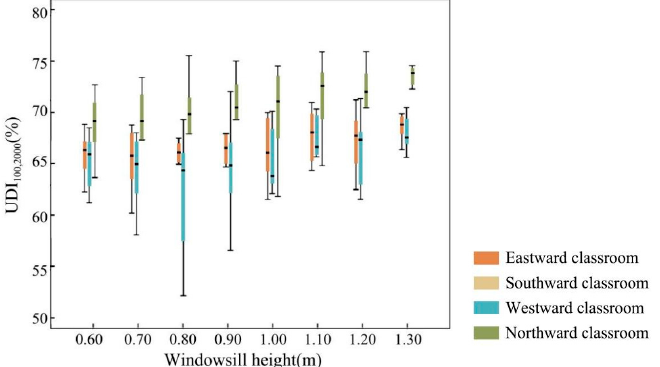
Figure 12. The analysis results of the distribution interval between the number of windows and the evaluation index. Figure 11. The analysis results of the distribution interval between the windowsill height and the evaluation index.